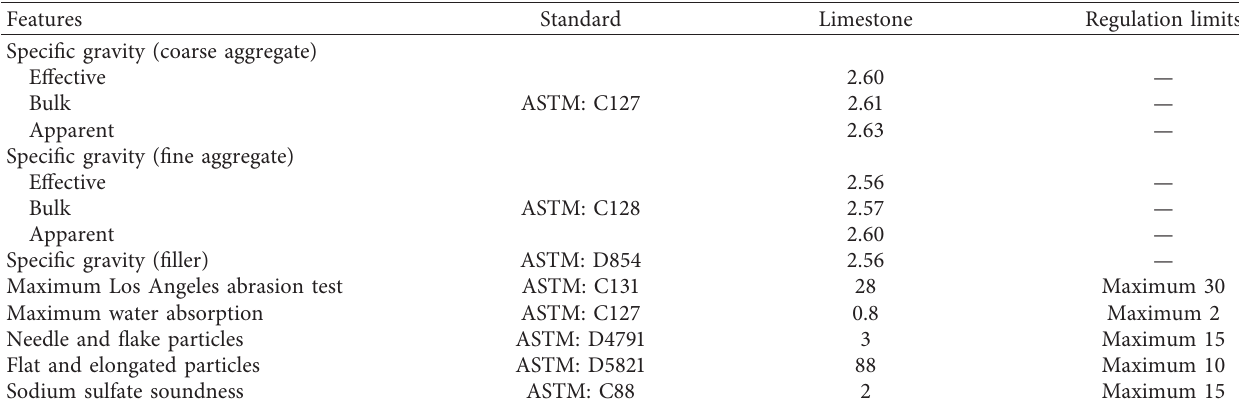
Table 1: The physical features of the aggregate.